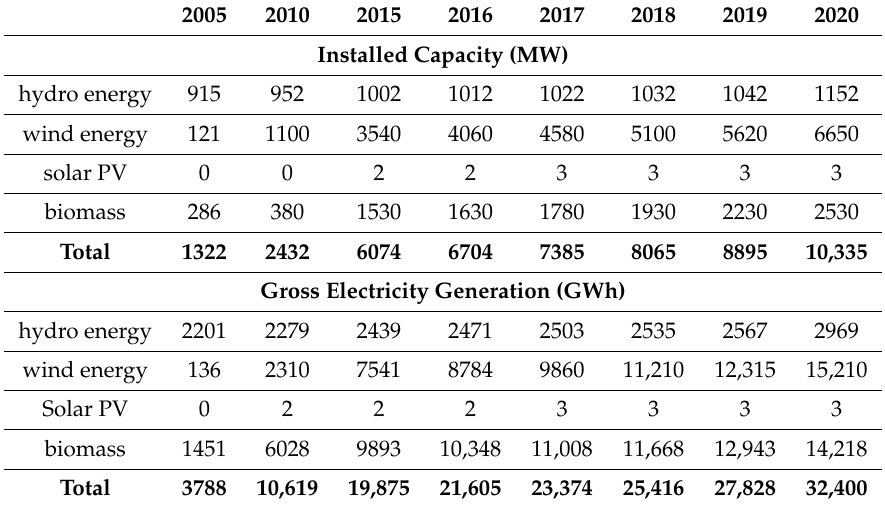
Table 4. Data from National Action Plan for renewable energy sources towards achieving the 2020 target